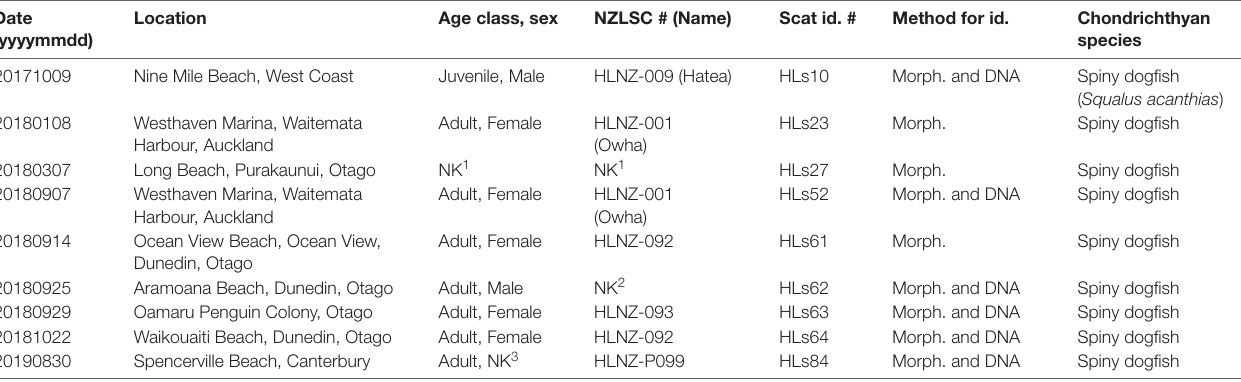
TABLE 6 | Scats collected which showed evidence of leopard seals ( Hydrurga leptonyx ) predating on chondrichthyans in New Zealand